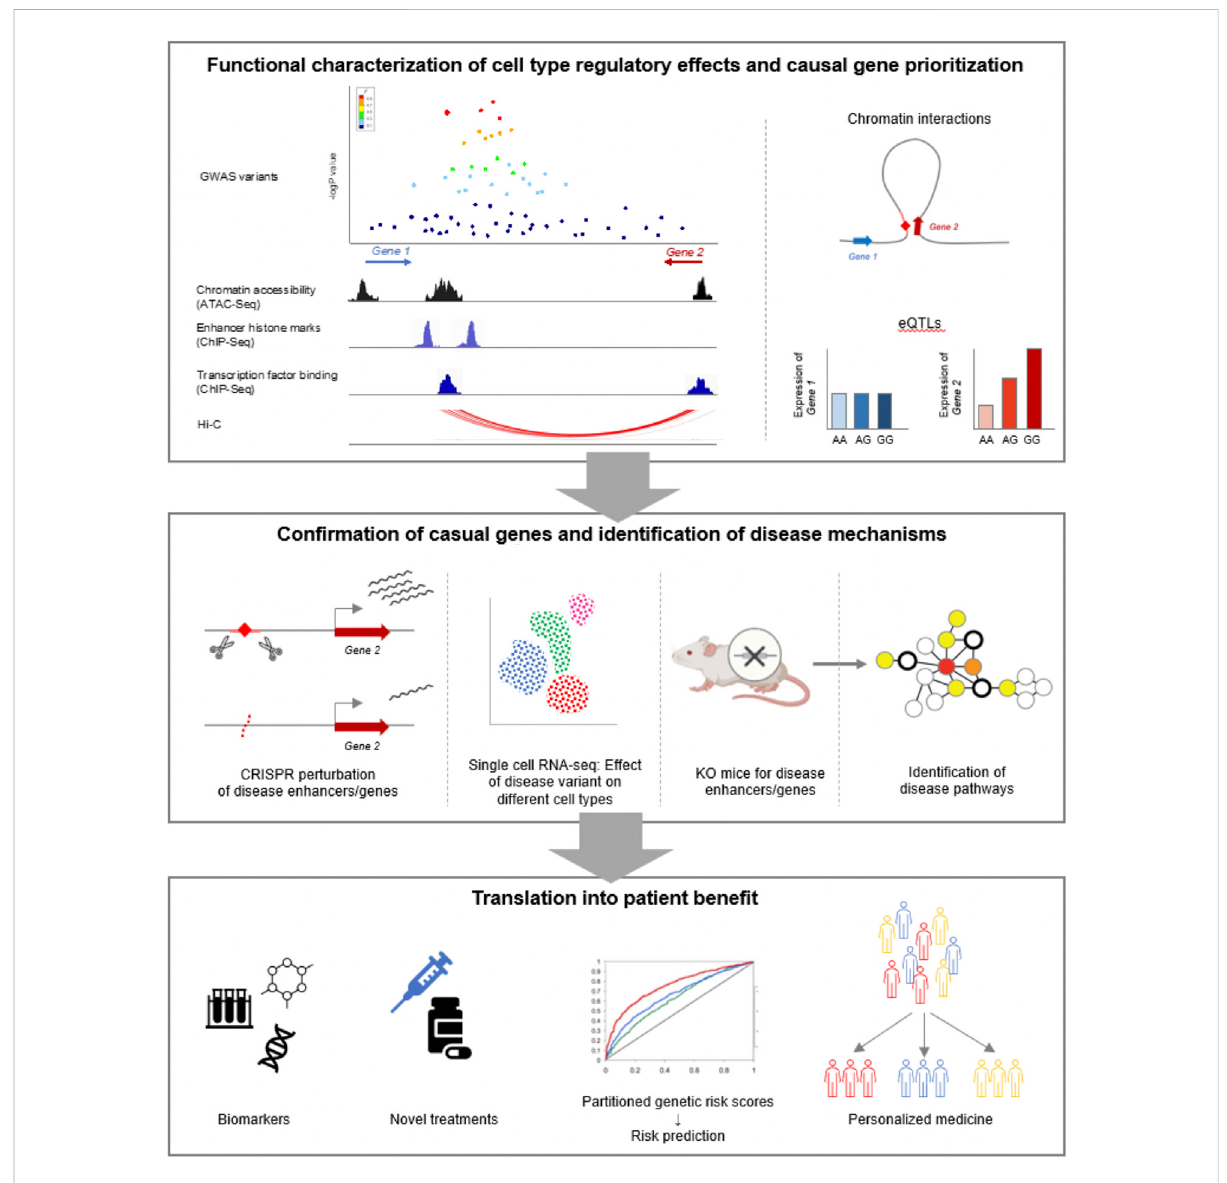
FIGURE 3 Overview of work fl ow for translating GWAS data into clinical bene fi t for